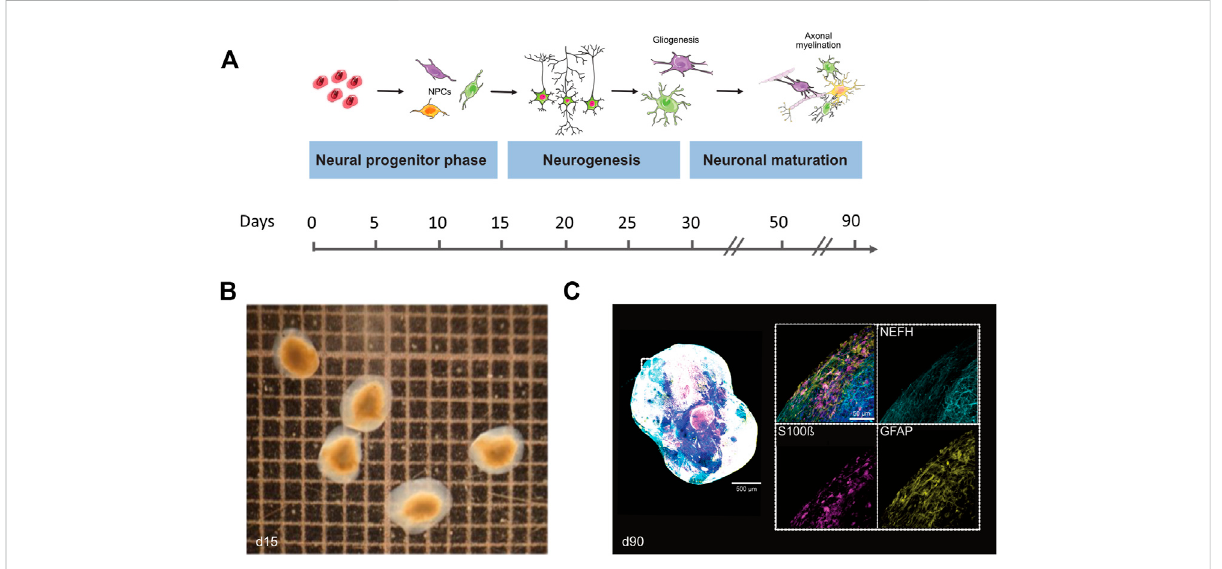
FIGURE 5 Differentiation and cellular composition of Bioengineered Neuronal Organoids (BENOs). (A) Scheme illustrates the different stages of BENO generation. Between days 0 – 10, neuroectodermal commitment is induced by dual smad inhibition (SB and LDN) and the presence of all-trans retinoic acid (RA). Neuronal progenitor cell growth is enhanced between days 10 – 15 by FGF-2 addition. Gliogenesis in BENOs is increased by addition of TGFß-1 at days 10 – 30. From day 15 – 30, DAPT is added to BENO cultures to promote neuronal differentiation. BENO development can be divided into four distinct stages: (1) Neuronal commitment to neuronal progenitor cells (NPCs) at days 3 – 15, (2) Neurogenesis between days 15 – 28, (3) Neuronal maturation from day 28 onwards and (4) Gliogenesis (day 50 onwards) such as axonal myelination (day 90 onwards).